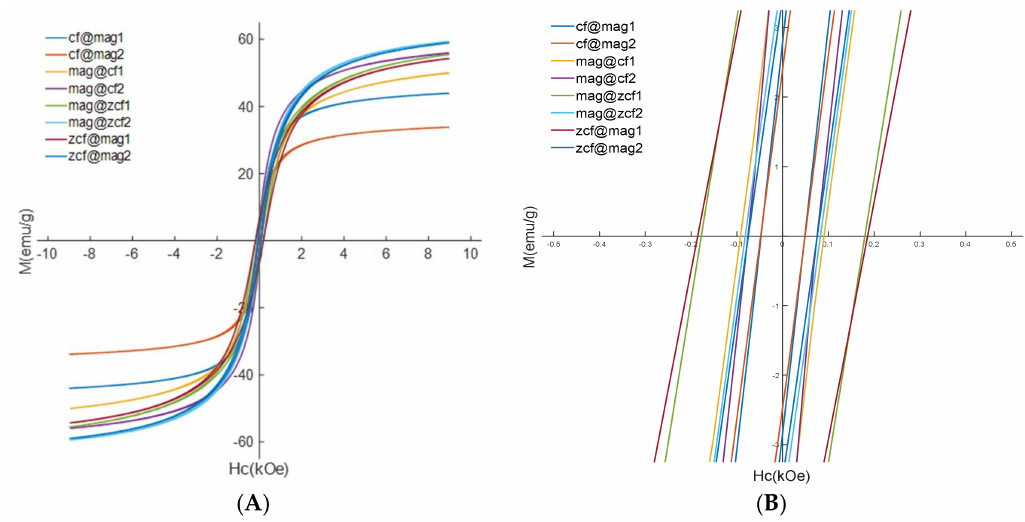
Figure 3. ( A ) Magnetic properties of the prepared core-shell MFNs and ( B ) Closed-up around the zero-field